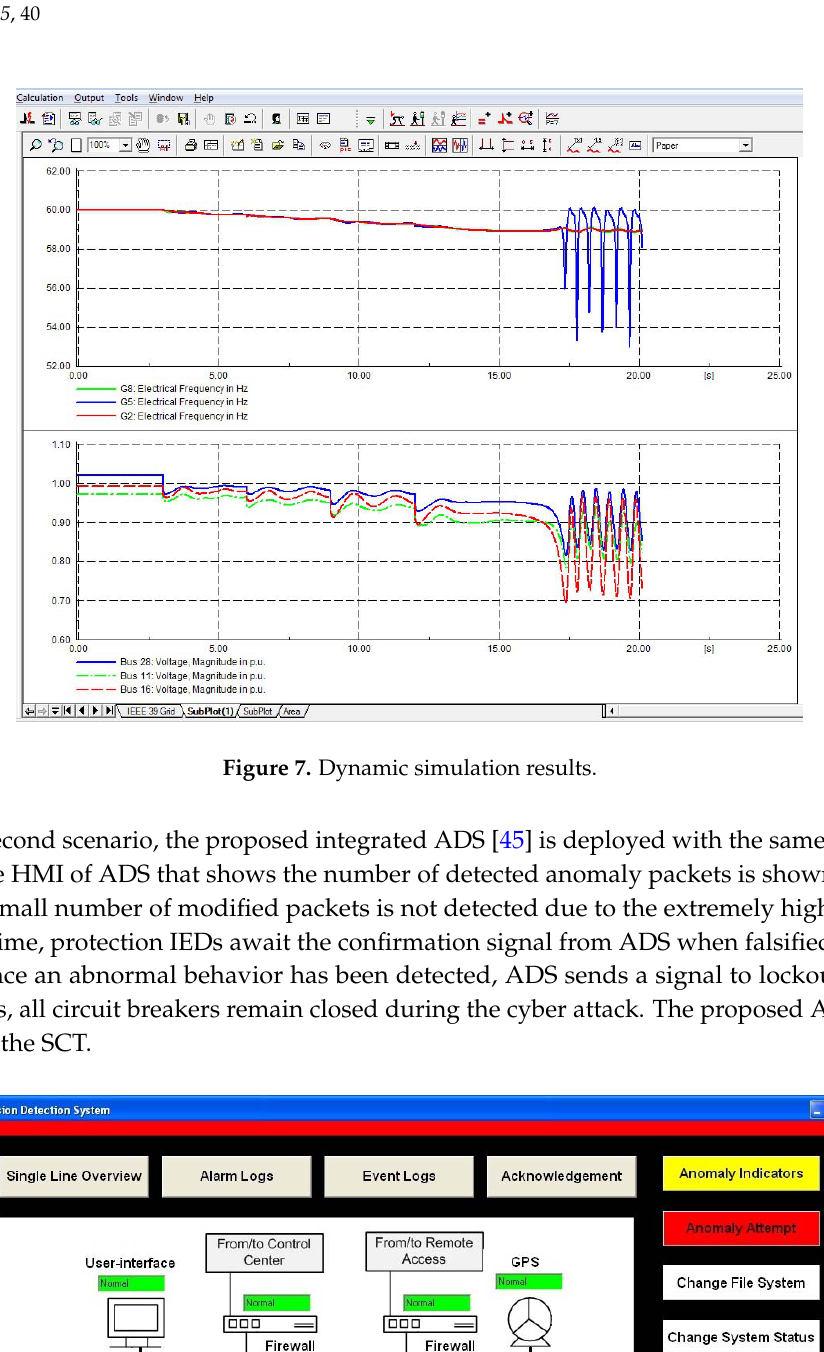
Figure 6. One ‐ line diagram of IEEE 39 ‐ bus system. The targeted substations and generators are marked in blue.